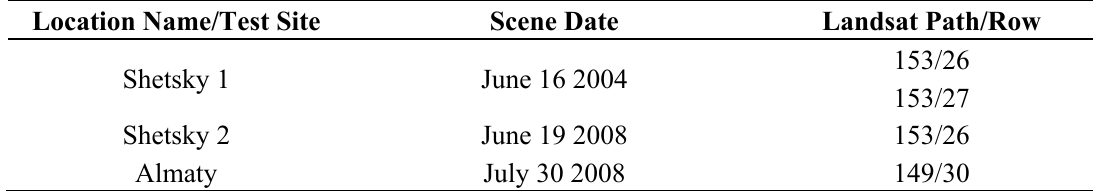
Table 2. The location and acquisition time of the Landsat images used in this